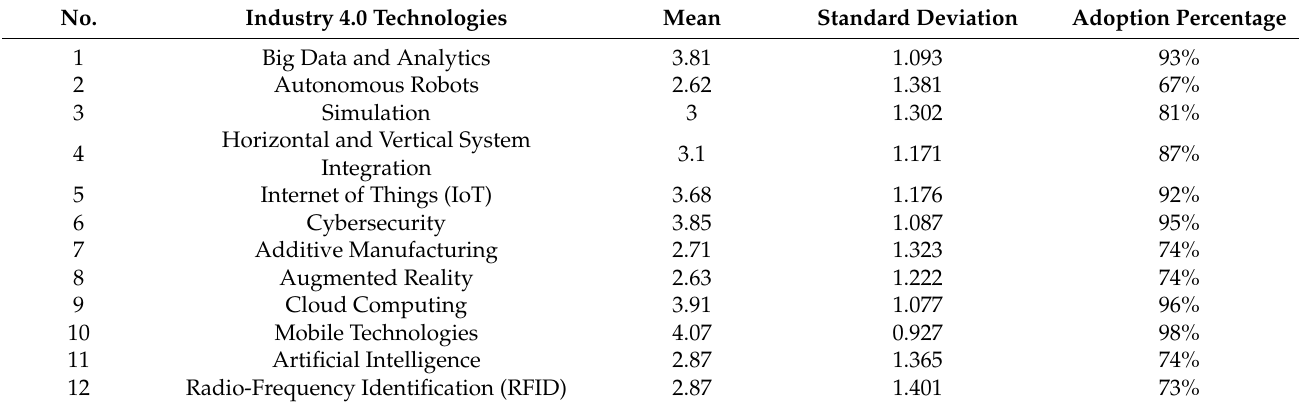
Table 4. Industry 4.0 technologies (mean, standard deviation and adoption percentage).